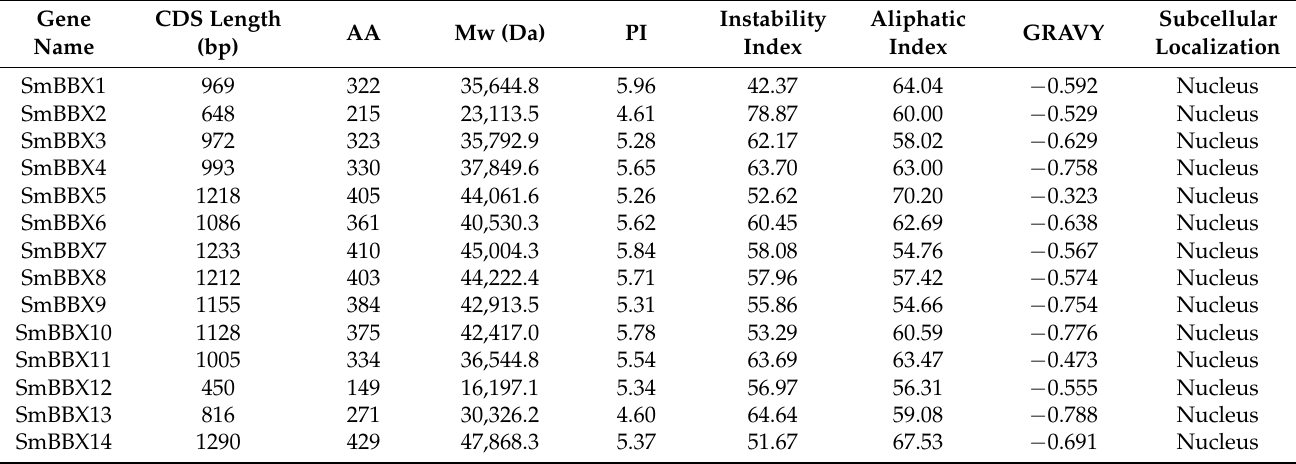
Table 1. Nomenclature, CDS, peptide lengths, molecular weights (MW), theoretical isoelectric points (PI), instability and aliphatic indices, Grand Average of Hydropathicity (GRAVY) and subcellular localization of Salvia miltiorrhiza BBX gene